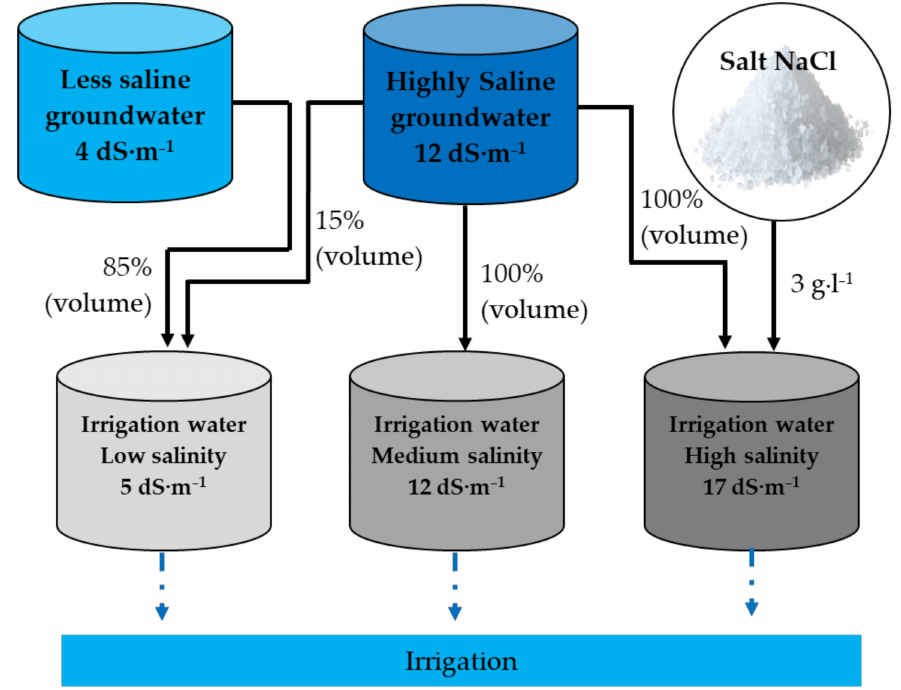
Figure 5. Schematic view of the irrigation water tanks laid out for using irrigation in the experimen- tal plots.